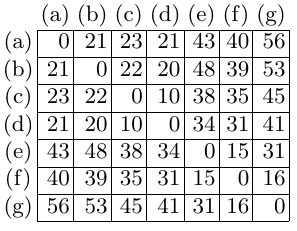
Table 1. Hamming-distance matrix for parts of the glycolysis and fructose/mannose metabolism pathways from seven different